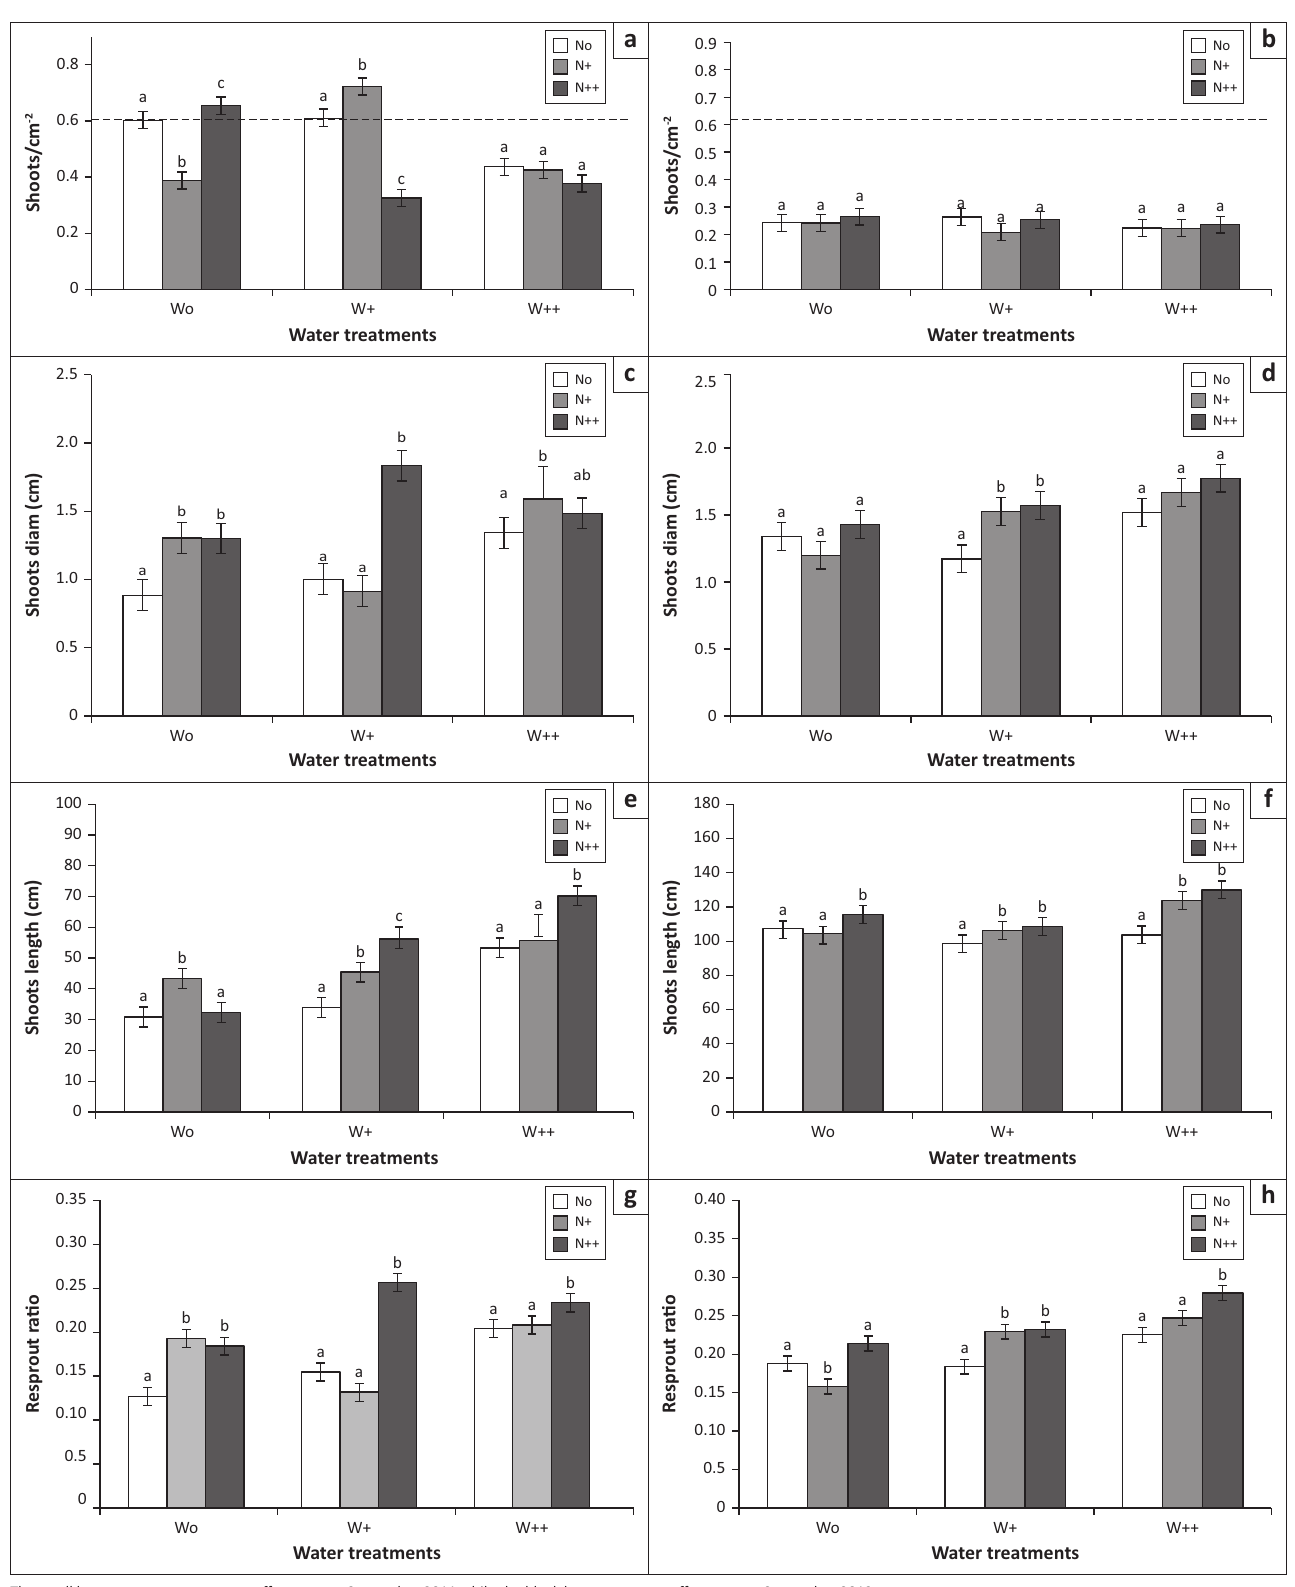
The small letters compare treatment effects across September 2011 while the block letters compare effects across September 2012. The asterisks indicate treatment differences between the two time points (September 2011 and September 2012). The means are represented with standard error bars. (a and b), The dashed line indicates the drop in shoot production across treatments and between the two time points (September 2011 and September 2012). (a, c, e, g), September 2011; (b, d, f, h), September 2012. W, water treatment; N, nutrient addition. FIGURE 3: Effects of water and nutrient addition on (a and b) shoot production (calculated as number of shoots per unit area of original stump circumference cm 2 ), (c and d) shoot diameter, (e and f) shoot length and (g and h) resprout ratio (calculated as the ratio of the tree’s original stump diameter to that of the leader shoot resprout diameter) between September 2011 and September